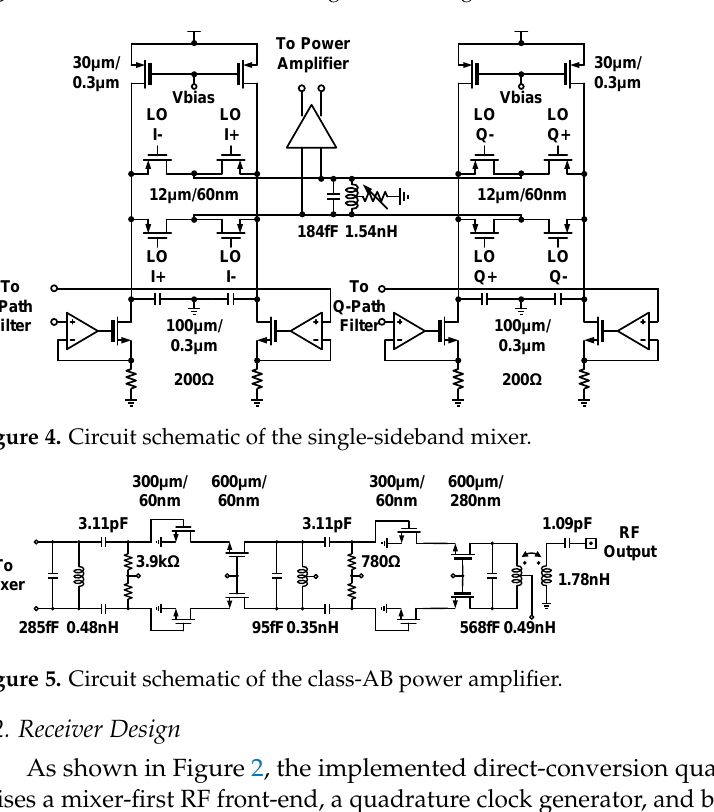
Figure 3. Circuit schematic of the digital-to-analog converter.